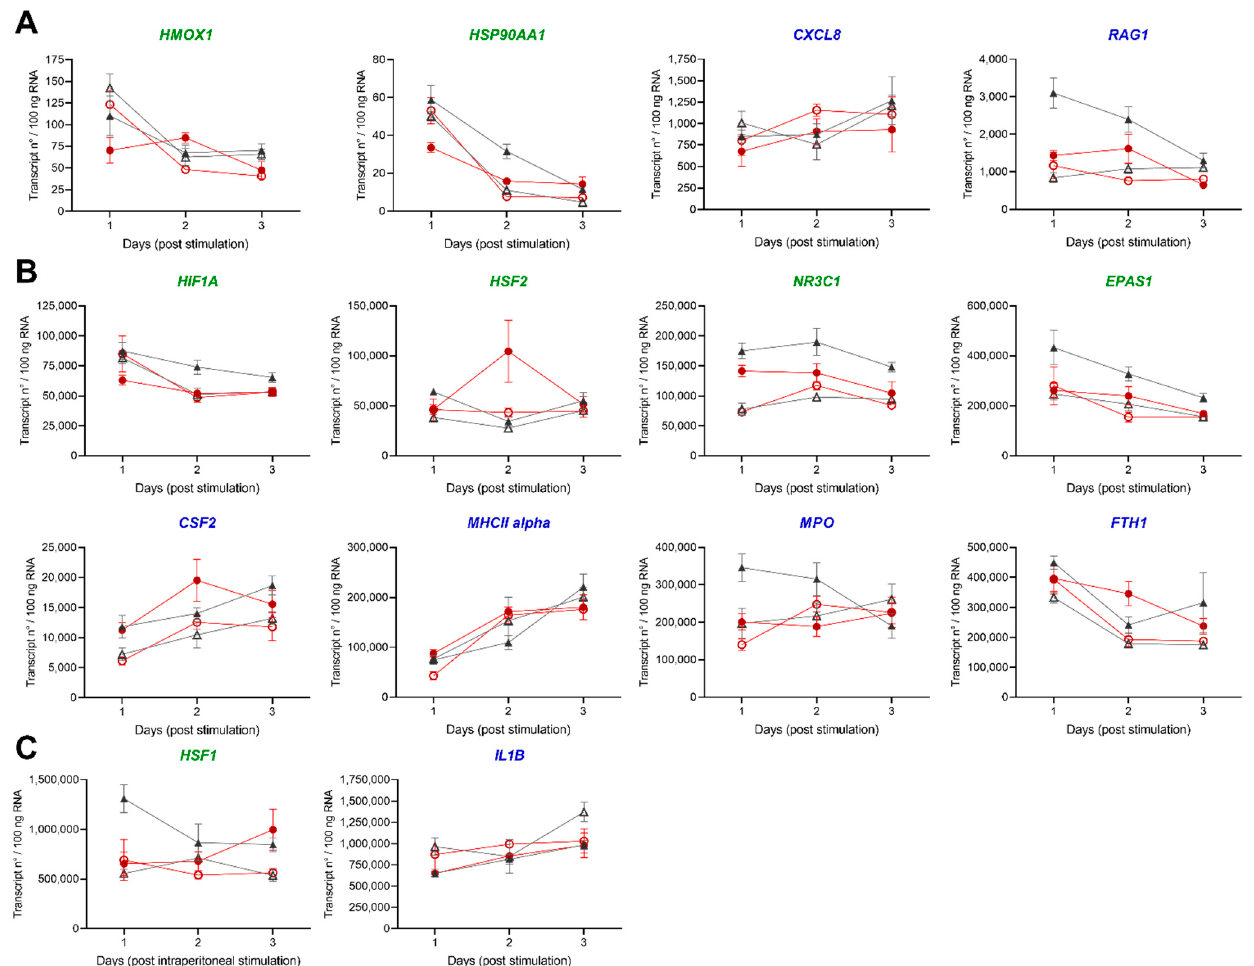
Figure 8. Expression of stress and immune markers in HK of pikeperch upon acute peritoneal inflammation. Expression of candidate genes in head kidney (HK) of pikeperch. Normoxic control group (grey), either unstimulated (grey/filled triangles) or stimulated (grey/empty triangles), and low DO treatment groups, either unstimulated (red/filled circles) or stimulated (red/empty circles) after one, two and three days post intraperitoneal stimulation with inactivated Aeromonas hydrophila cells. Genes involved in stress (green) or immune response (blue) are either lowly ( A ), moderately ( B ) or highly ( C ) expressed. Data points represent mean of four individual samples (+SEM), calculated per 100 ng of total RNA. Statistically significant differences were calculated via one-way ANOVA followed by Tukey‘s multiple comparison test ( p = 0.05).